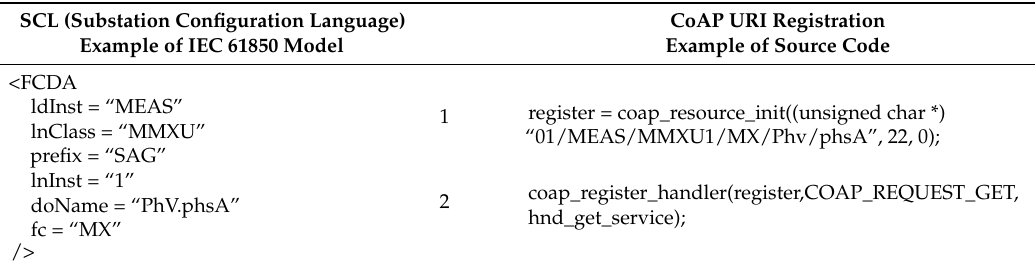
Table 2. Example of a SCL IEC 61850 Model to CoAP URI Source